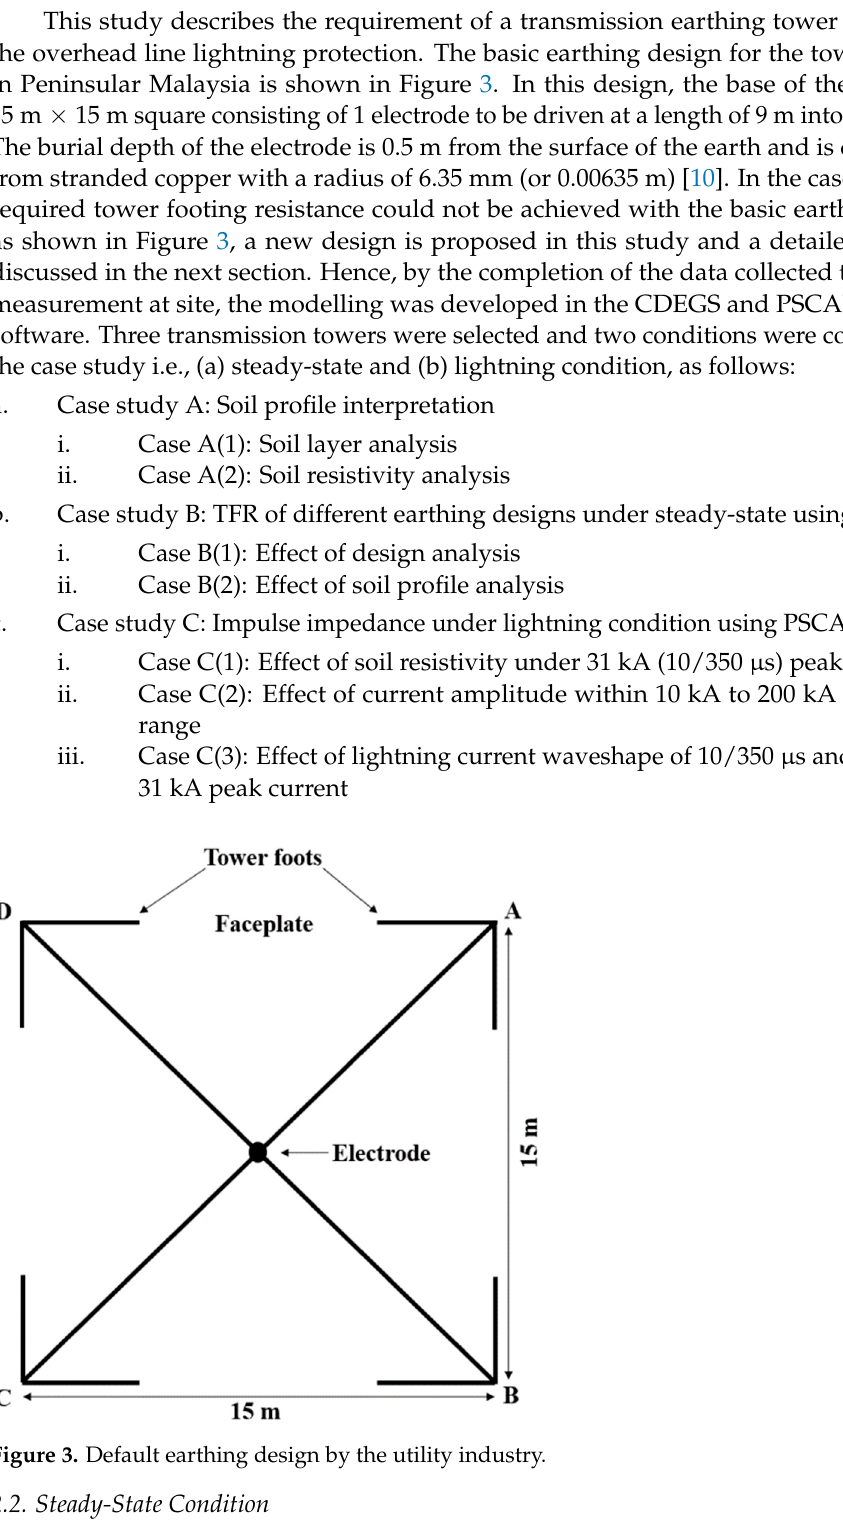
5 of 20 Table 2. Line performance comparison for 500 kV lines in TNB.